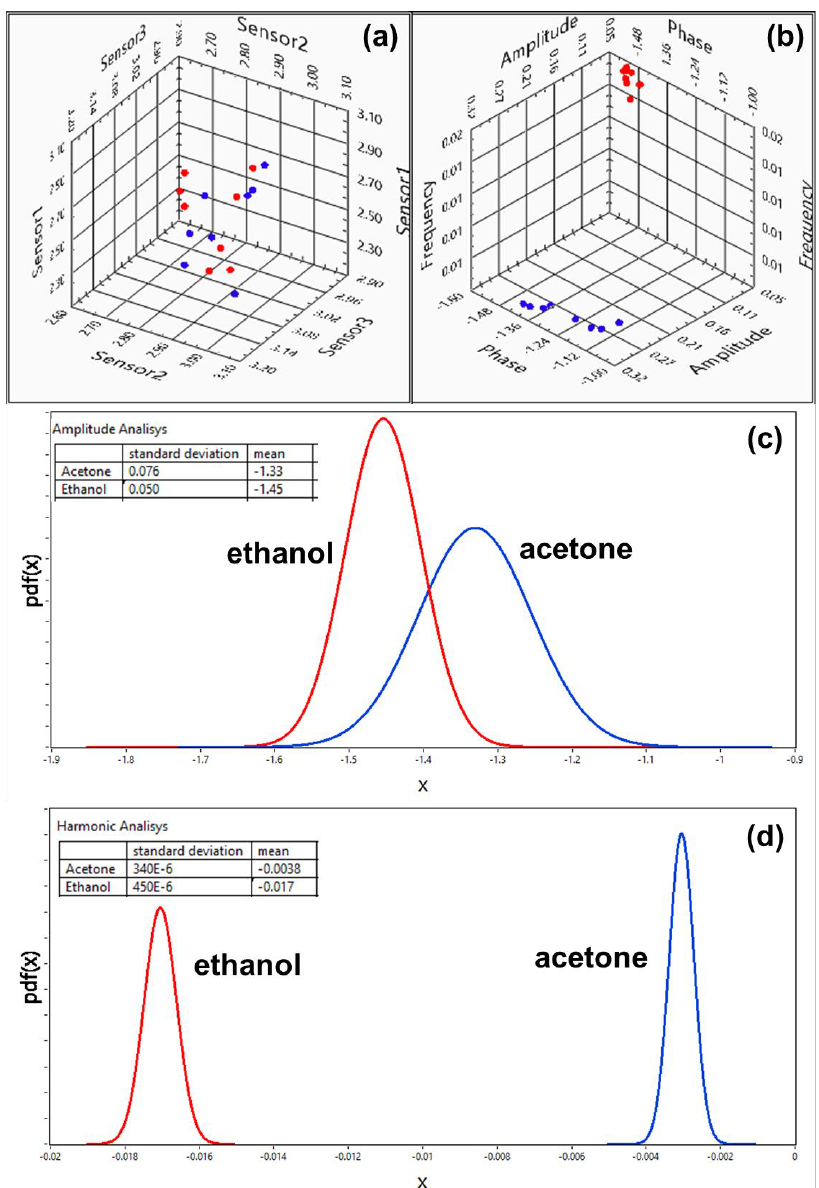
Figure 7. Separation of classes in the ( a ) hyperspace of steady-state responses of multi-sensory system ( b ) sub-space of the first harmonic extracted from the transient response. Probability density for acetone and ethanol for steady-state ( c ) and harmonic ( d ) analysis. Coordinate x was obtained by transformation of coordinates according to Fisher’s criteria of